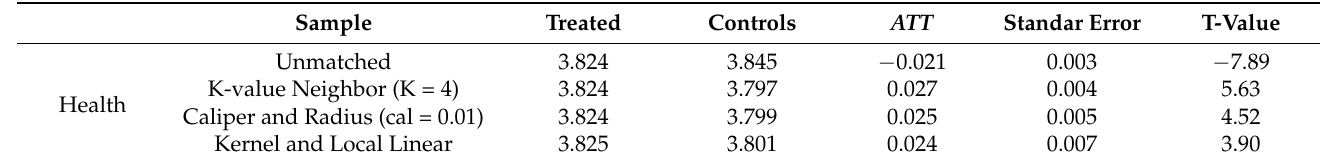
Table 4. The results of propensity score matching.